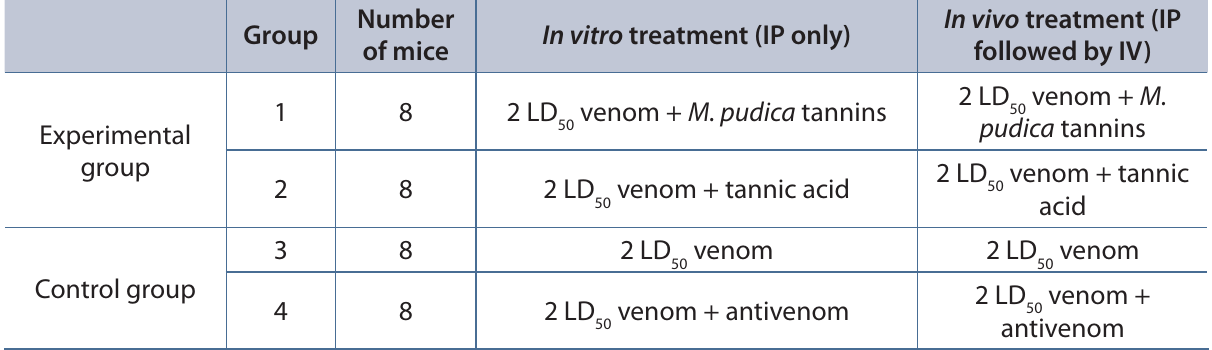
Table 1. The different treatment groups of mice for both in vitro and in vivo studies